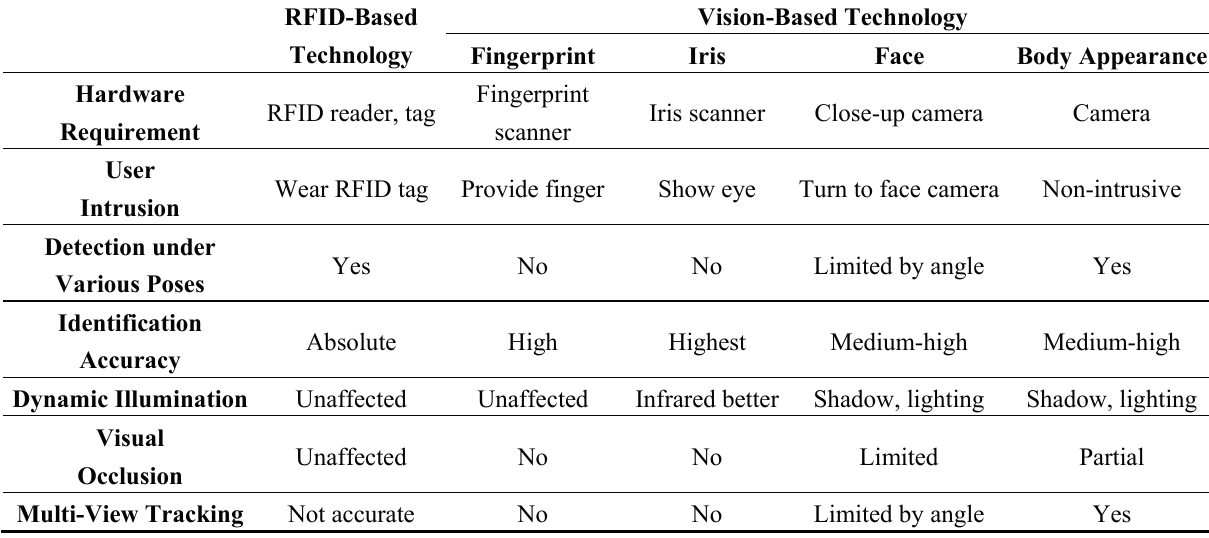
Table 1. Comparison of various sensors for human detection, tracking, and identification at